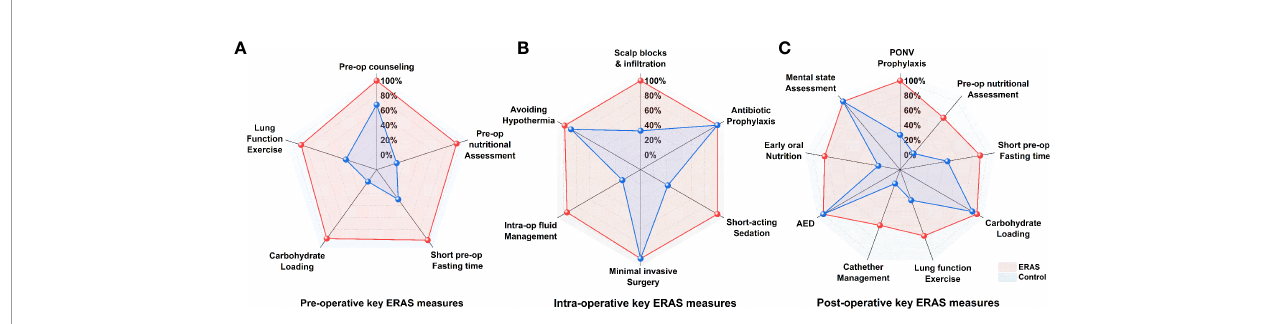
FIGURE 3 | Percent compliance with the ERAS core elements between ERAS groups and control group, categorized by pre-operative (A) , intra-operative (B) and post-operative (C) key measures.